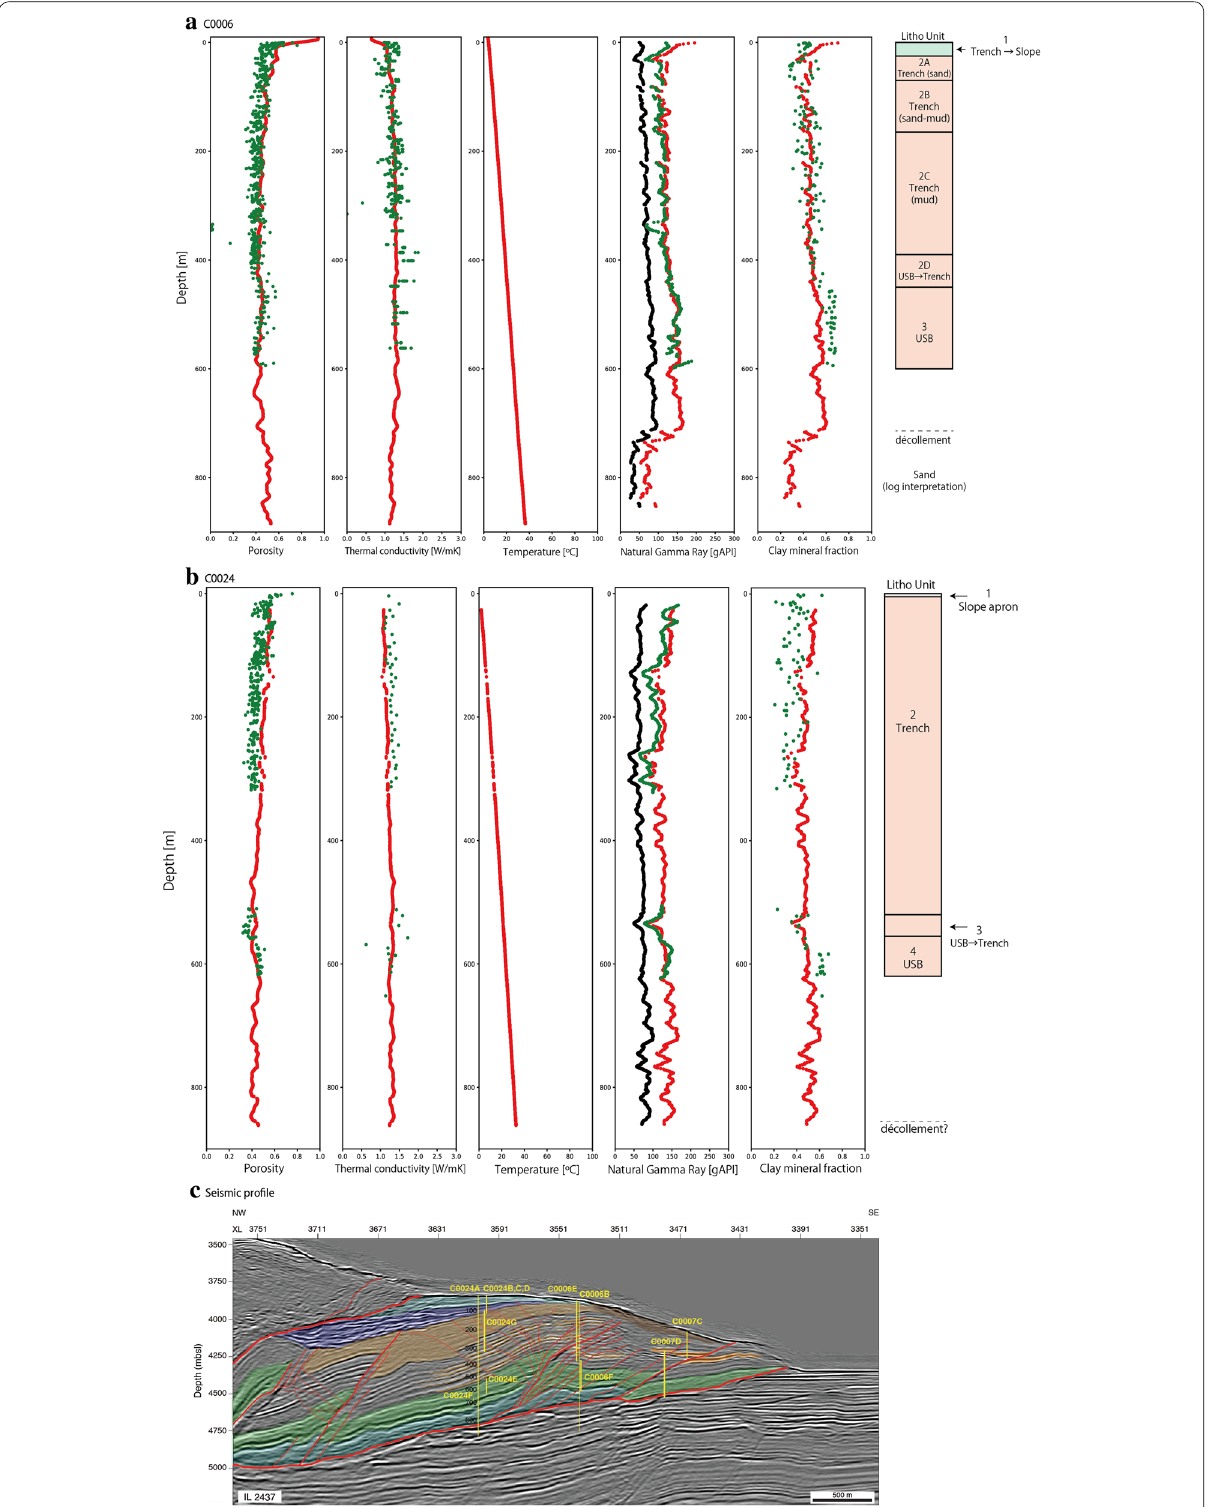
Fig. 3 Data from the toe sites. a Site C0006, b site C0024, and c a seismic profile around the prism toe after Figure F7 of Tobin et al. (2020). Symbols are the same as in Fig.